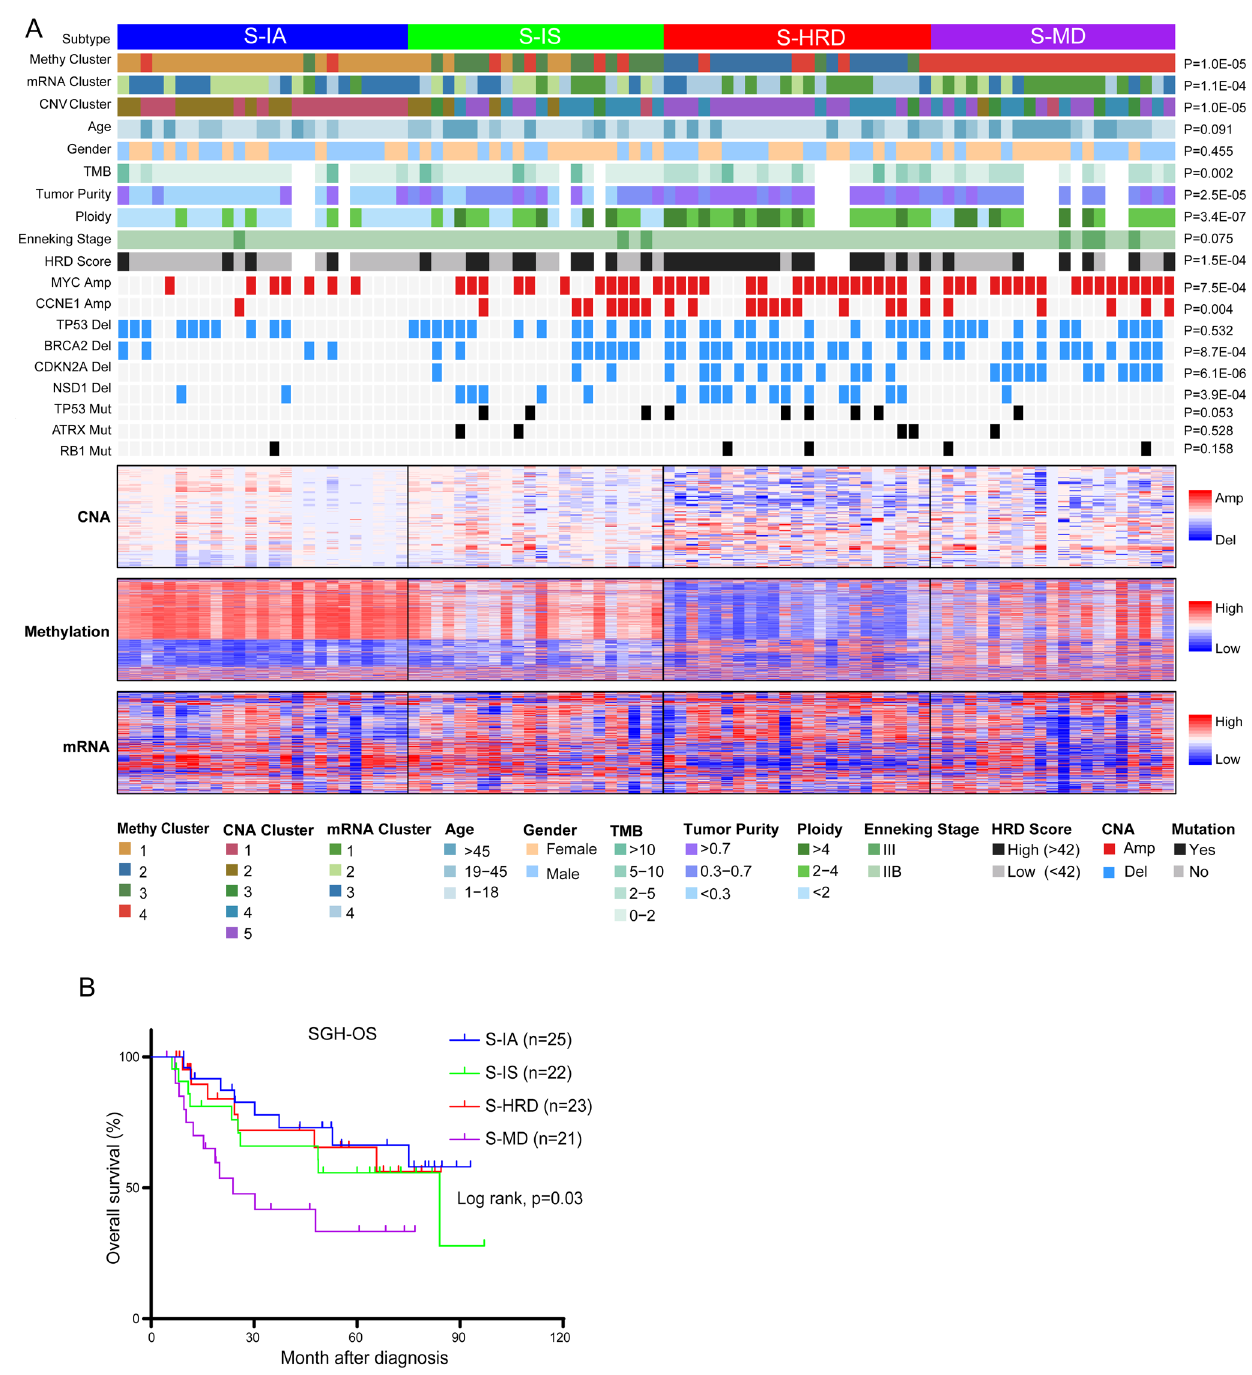
Fig.4|Integrativesubtypeswithdistinctmolecularfeaturesandvariedclinical prognosis. A Integrative clustering of 91 patients. Top, left to right: immune- activated subtype (S-IA, iCluster1), immune-suppressed subtype (S-IS, iCluster2), HRD dominant subtype (S-HRD, iCluster3) and MYC driven subtype (S-MD, iClus- ter4). Single platform clustering results: DNA methylation cluster, mRNA